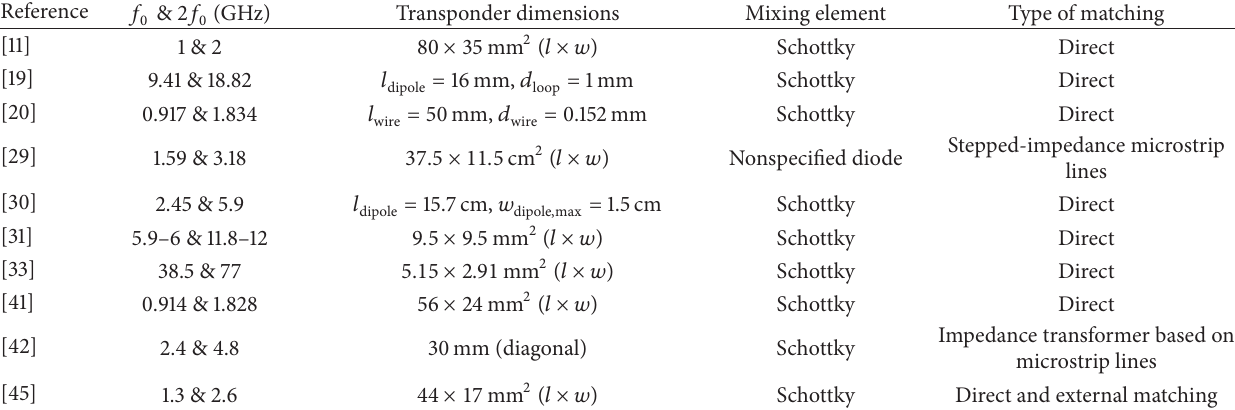
Table 1: Summary on the features of some harmonic radar tags found in the literature.